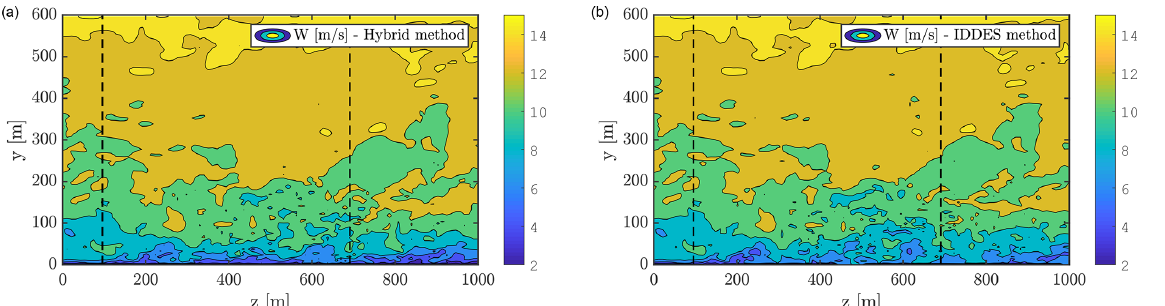
Figure 10. Velocity W downstream of rotor.